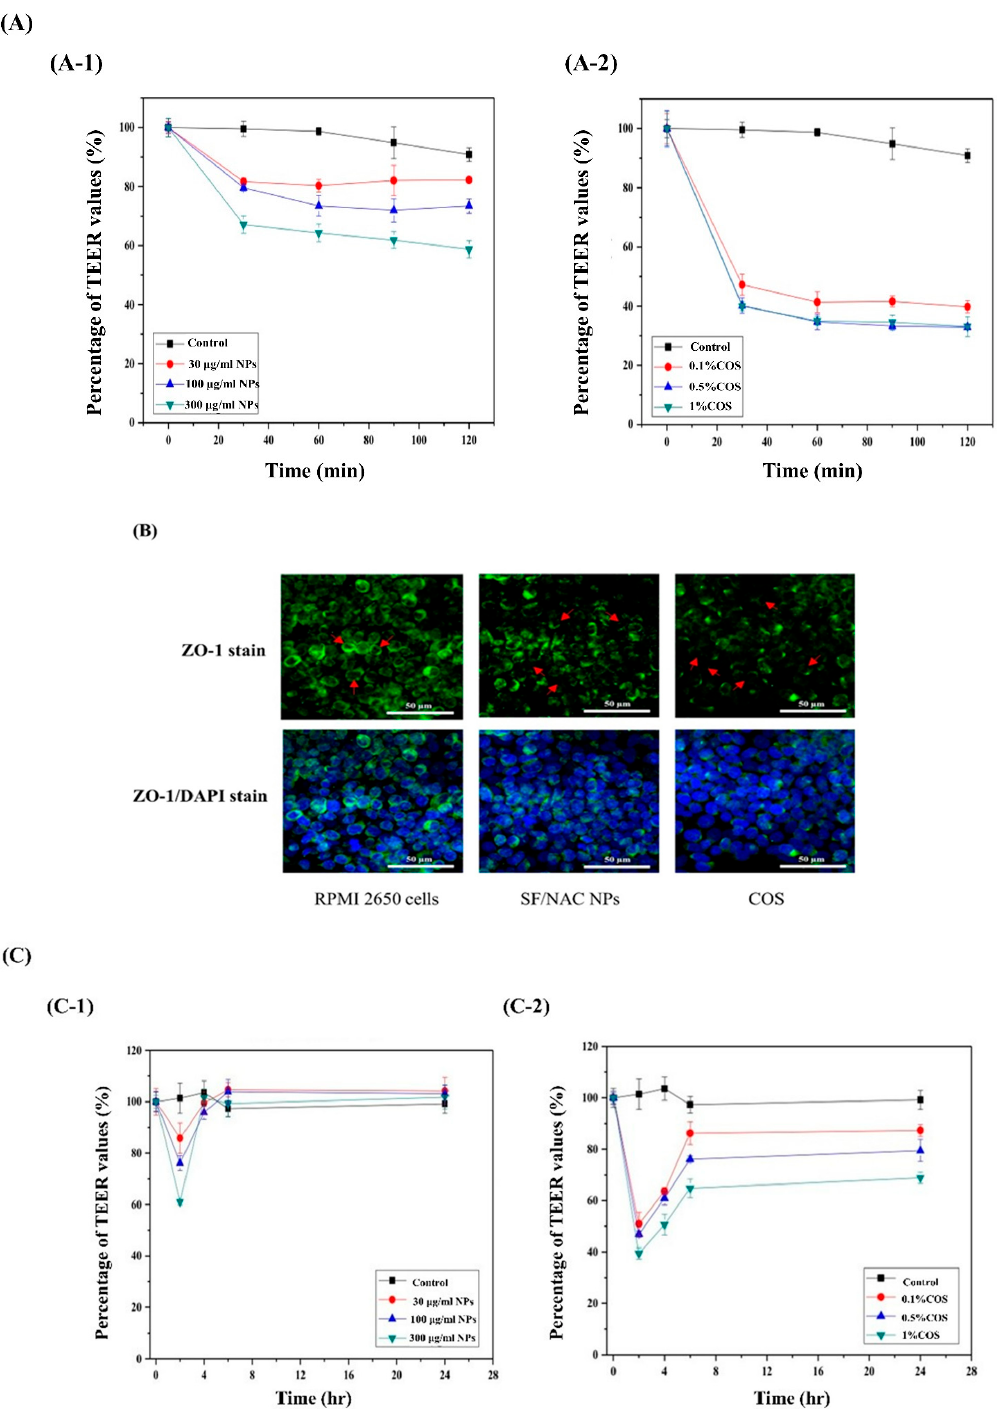
Figure 5. ( A ) The dynamics of TEER values for a RPMI 2650 cell layer that was incubated with various concentrations of ( A-1 ) SF/NAC NPs and ( A-2 ) COS for 2h (n = 3) at 30 min. There were fast